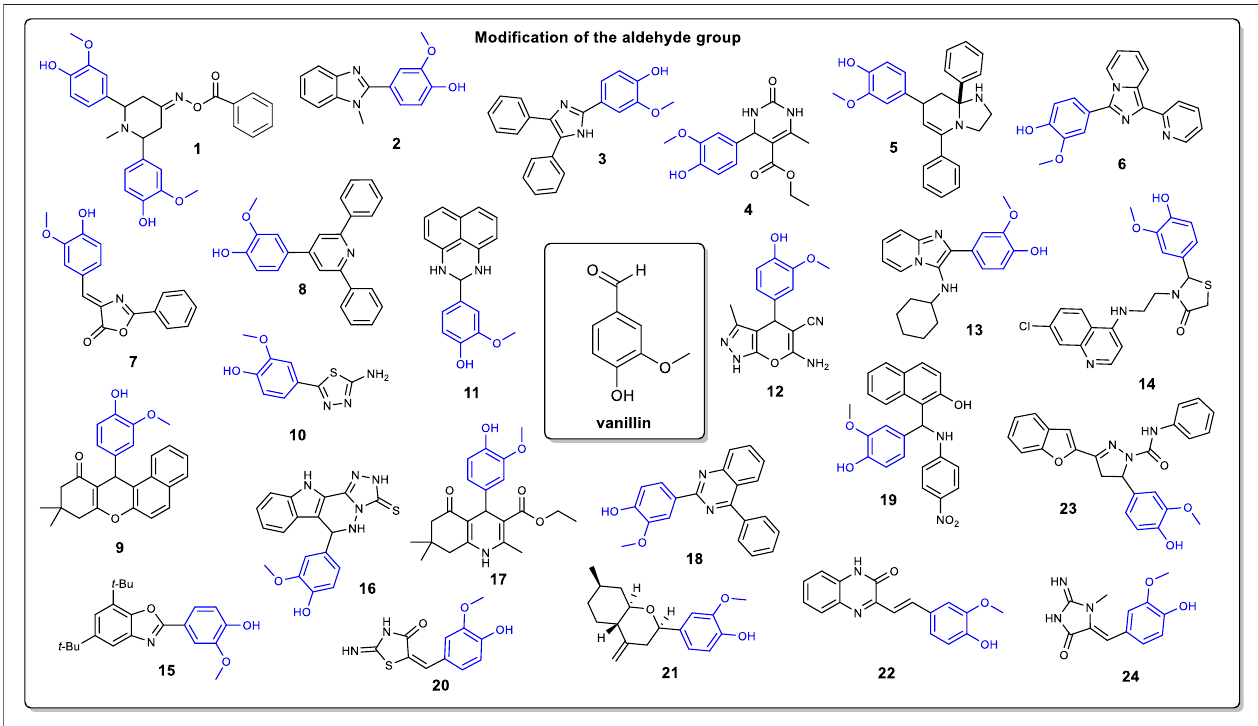
FIGURE 1 | Examples of the modi fi cation of the vanillin moiety through the aldehyde functional group.